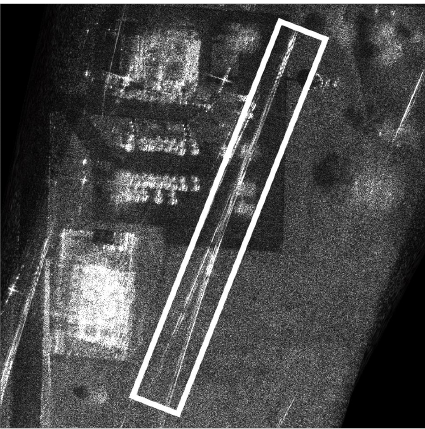
Figure 1. Image trace of a moving target with linear motion in a CSAR image. The figure is generated with the Gotcha GMTI dataset. The target signature is labeled with a white